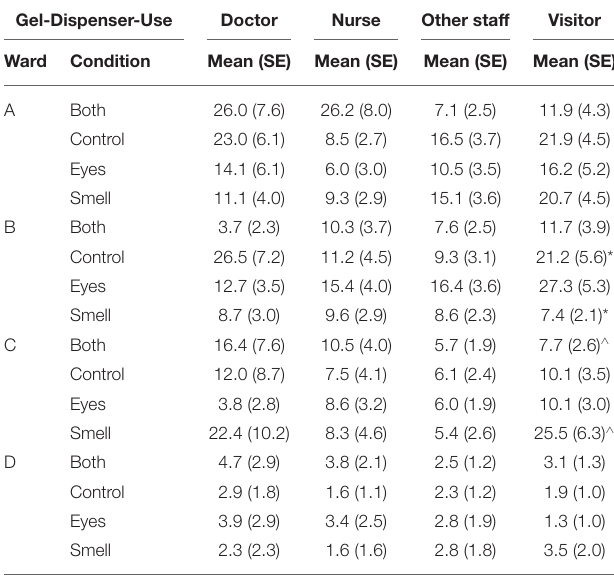
TABLE 5 | Model Means and standard errors pertaining to gel-dispenser-use and soap-dispenser-use, broken down by treatment condition and role in hospital.